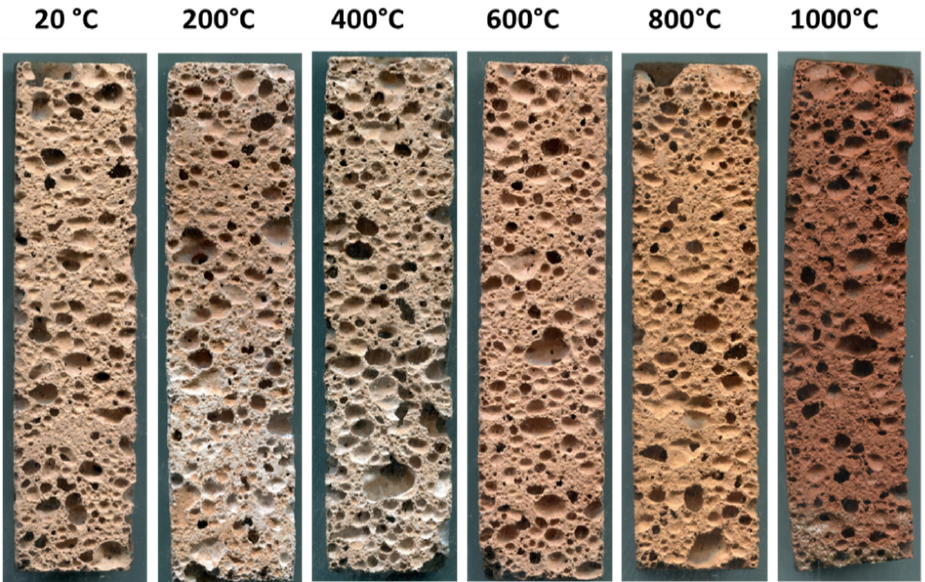
Figure 3. Visual aspect and colour change in heated geopolymer foam Al-1.